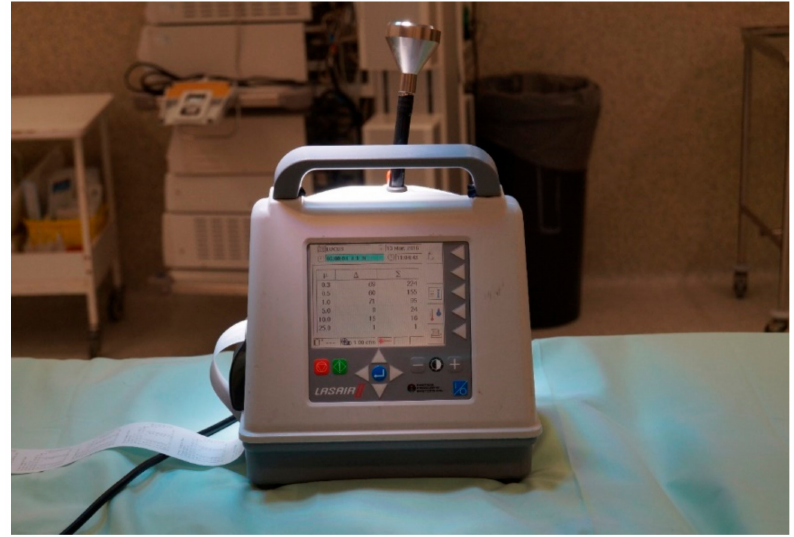
Figure 3. Particle measurement